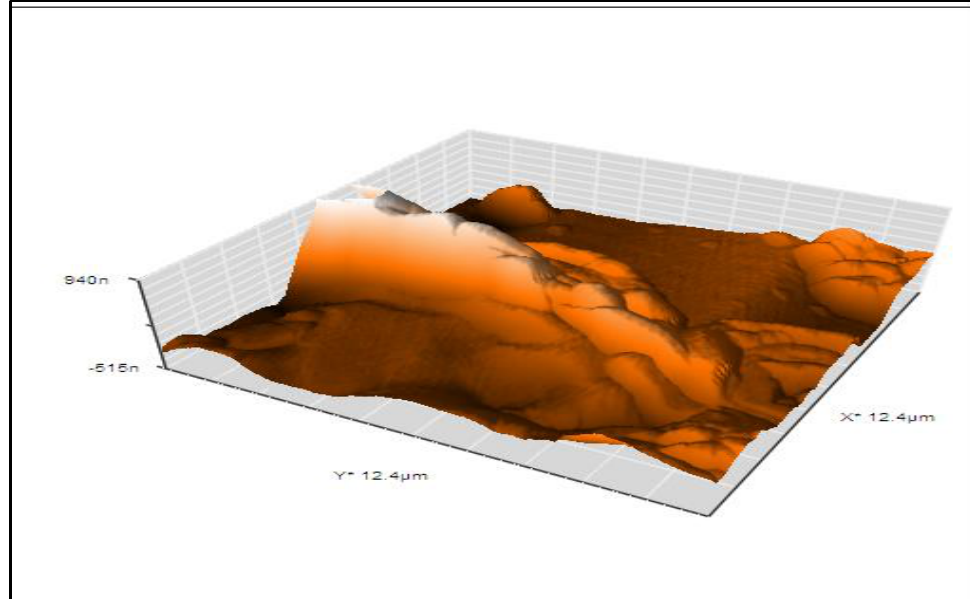
Figure12. AFM of mirtazapine pure powder